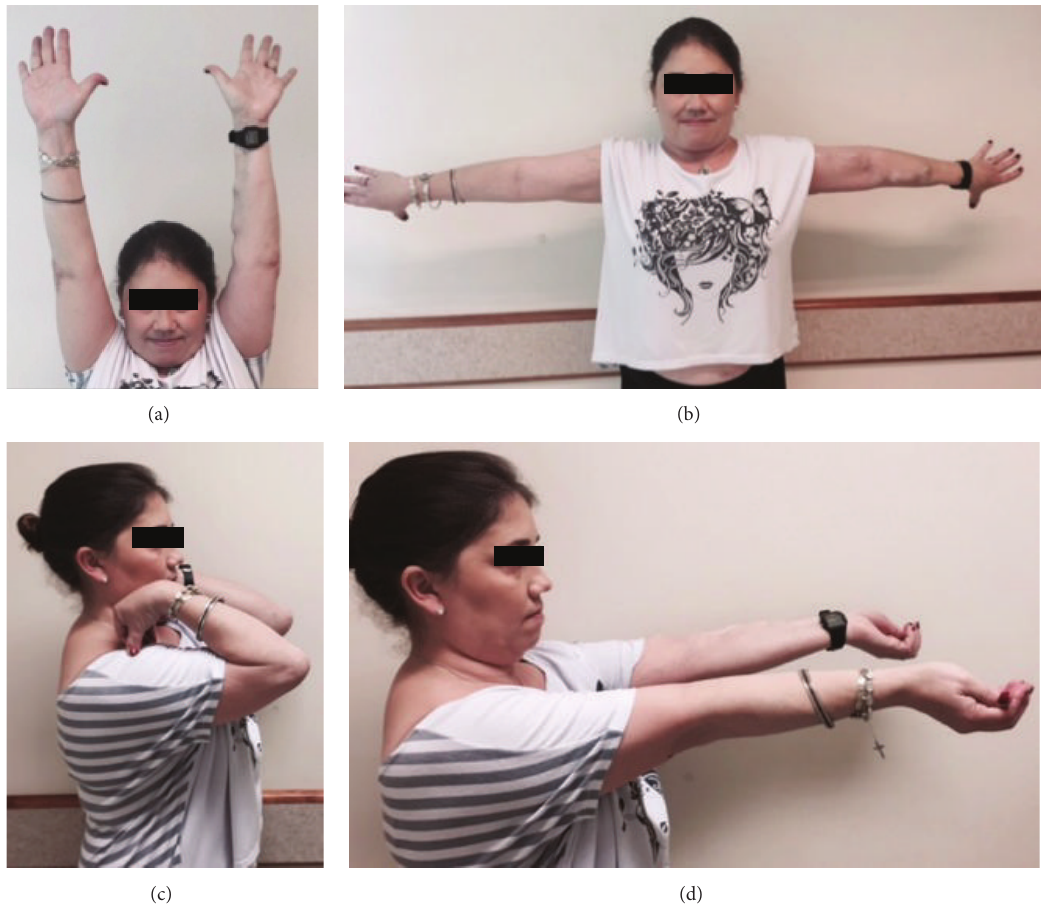
Figure 3: Clinical photograph showing elbow extension (a, b, and d) and flexion (c) at 3-month